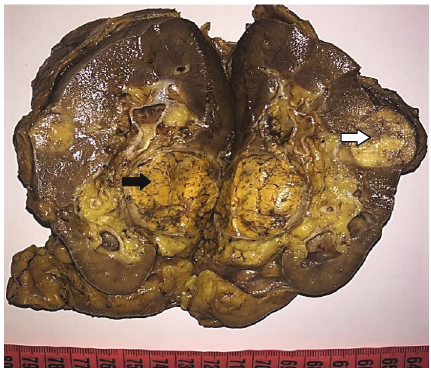
Figure 2: Gross examination revealing two di ff erent renal masses: the largest mass (black arrow) was encapsulated and fi rm composed of golden yellow soft areas with hemorrhagic changes. The smaller mass (white arrow) was well de fi ned and had yellowish, glistening cut